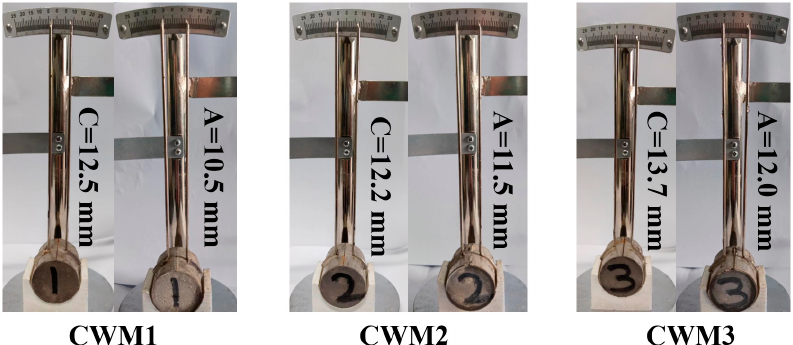
Figure 5. Comparison diagram of volume expansion test results of three CWMs.